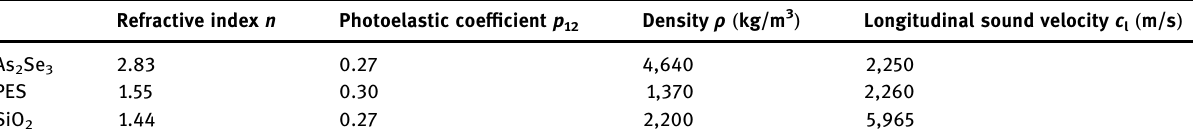
Table 1: Acoustic and optical physical parameters of As 2 Se 3 , PES, and SiO 2